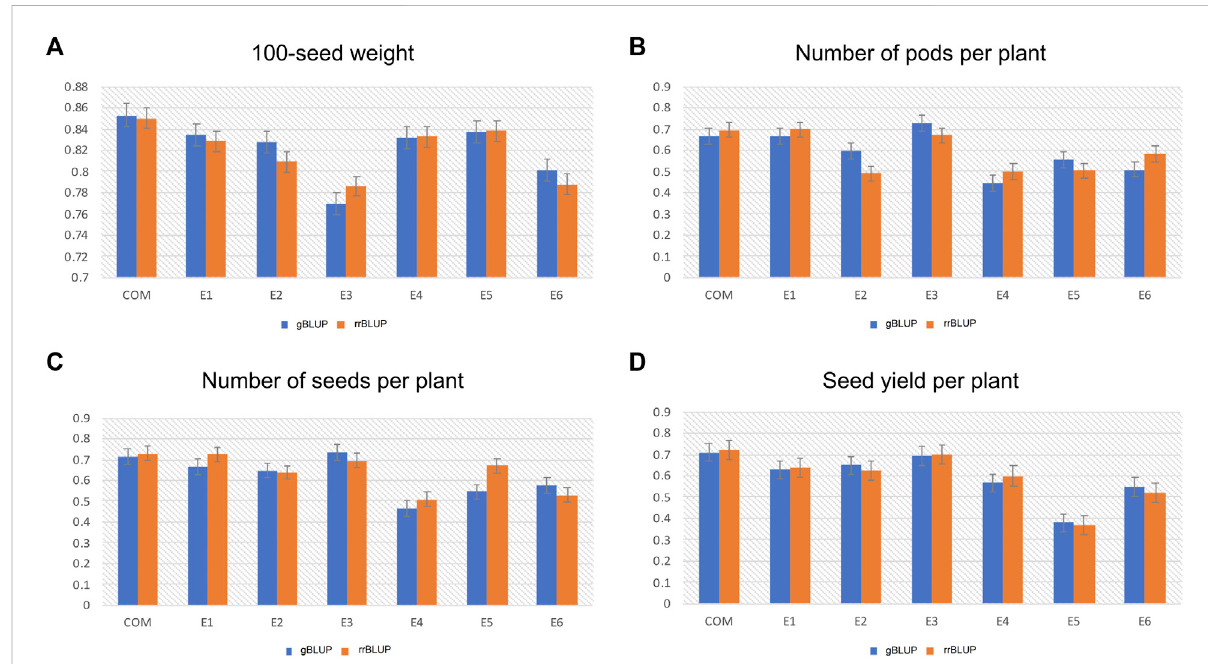
FIGURE 6 Histograms showing the genomic prediction accuracy of the genomic best linear unbiased prediction (gBLUP) and ridge regression best linear unbiasedprediction (rrBLUP) models for (A) 100-seed weight (HSW) (B) Number of pods per plant (PPP) (C) Number of seeds per plant(SPP), and (D) Seed yield per plant (SYP), across six different environments (E1, E2, E3, E4, E5, and